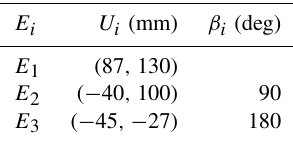
Table 1. Parameters of the